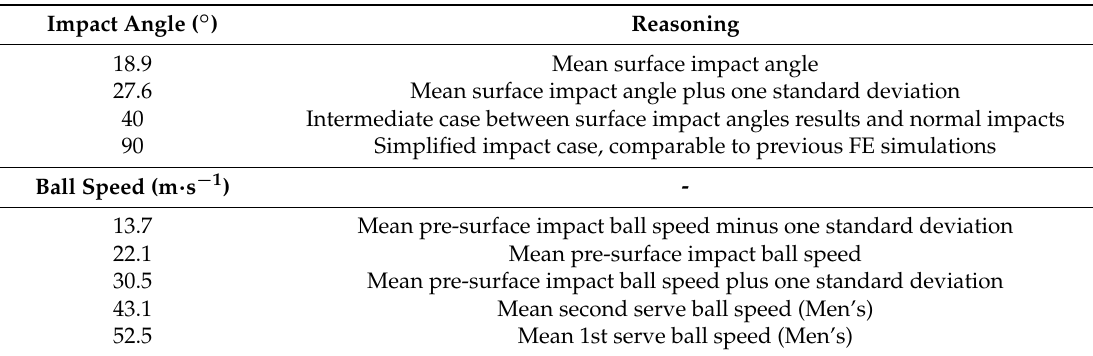
Table 3. Impact condition